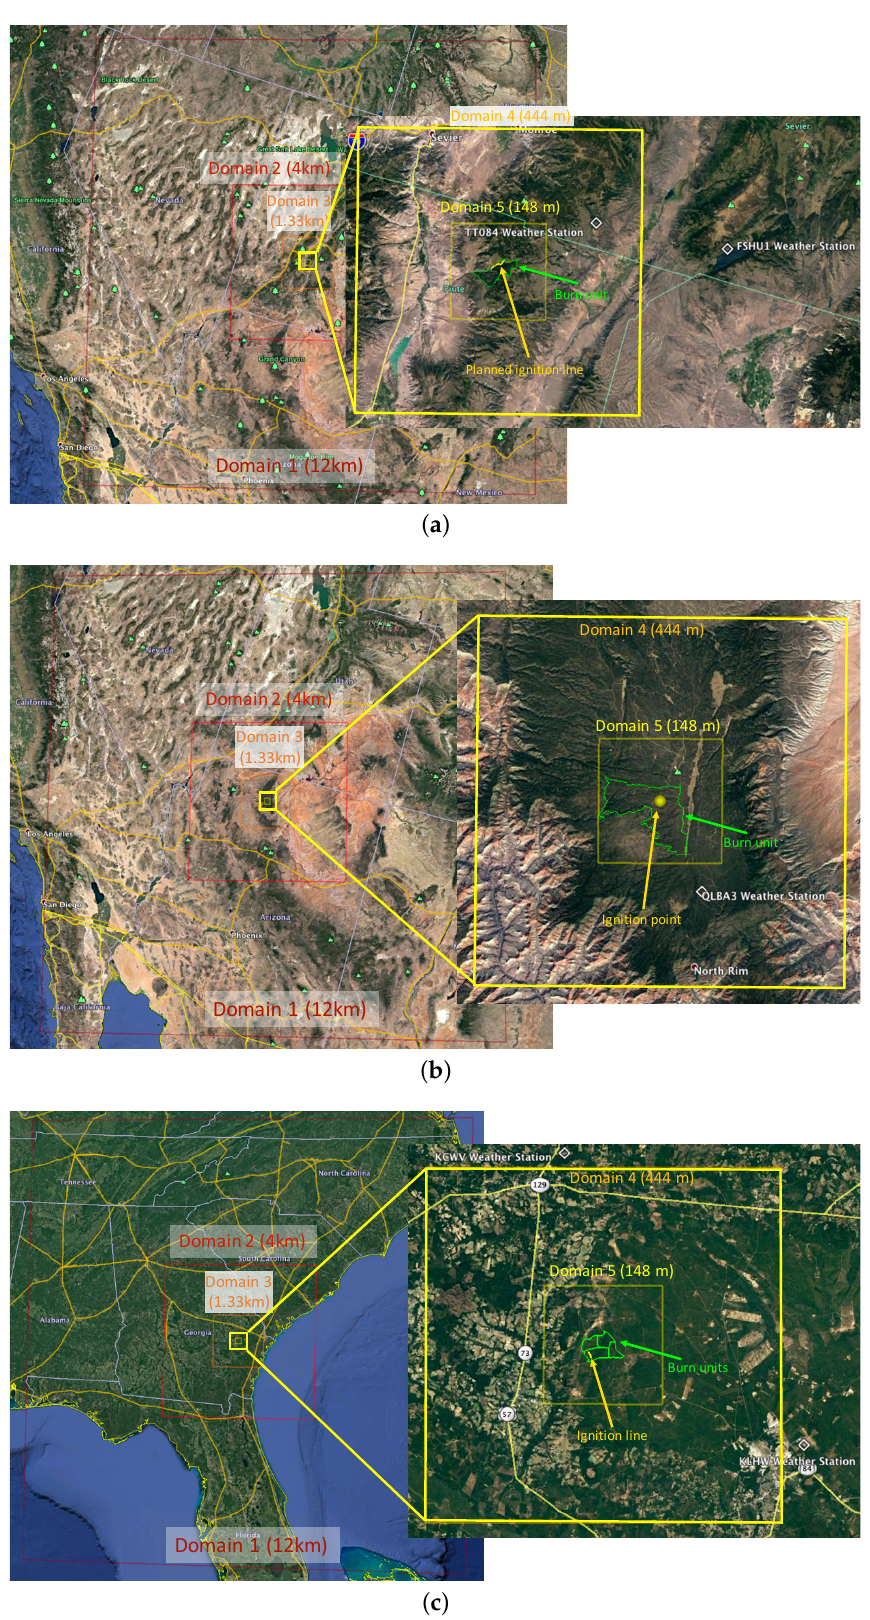
Figure 2. WRF domain setups for burn simulation: ( a ) Fishlake; ( b ) North Kaibab; ( c ) Fort Stewart, with indication of nearby meteorological stations used to define typical